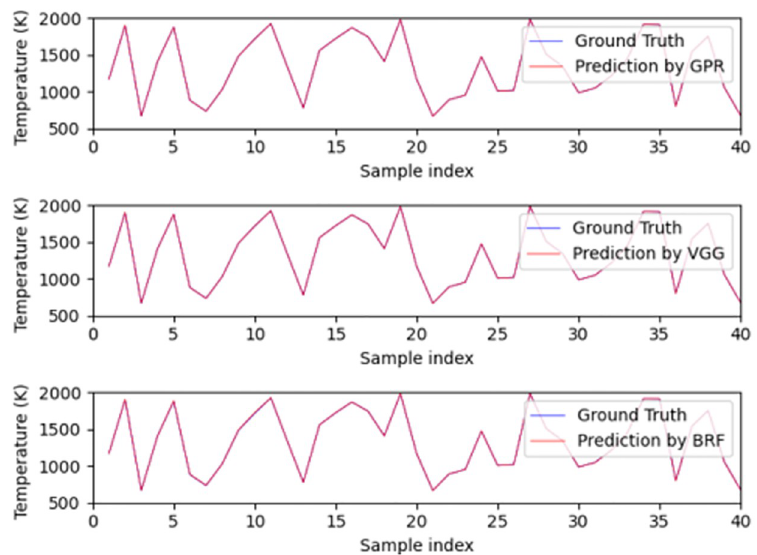
Fig 4. The performance of the best three models on the test set for the prediction of uniformly distributed temperature. The top, middle and bottom subplots are the predictions of GPR, VGG and BRF respectively.